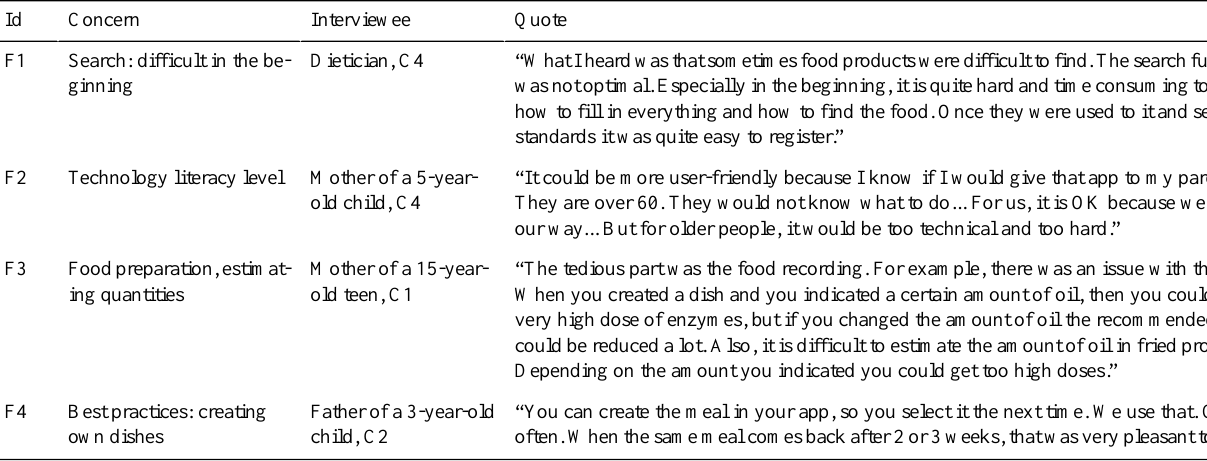
Table 6. Illustrative quotes related to using the self-management app: food